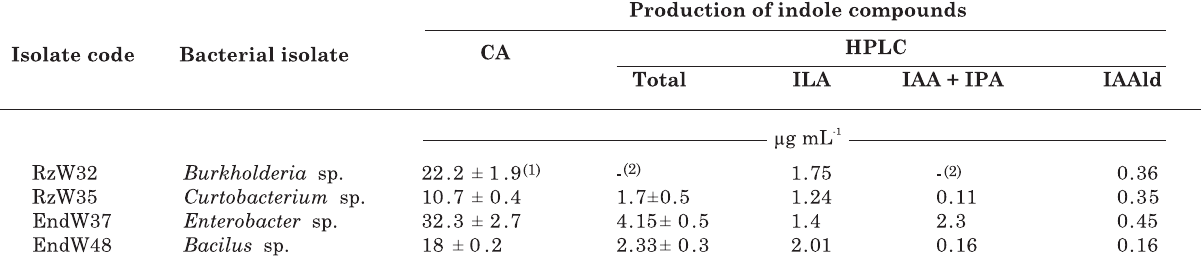
Table 2. Rhizobacterial auxin production in Czapek liquid medium supplemented with